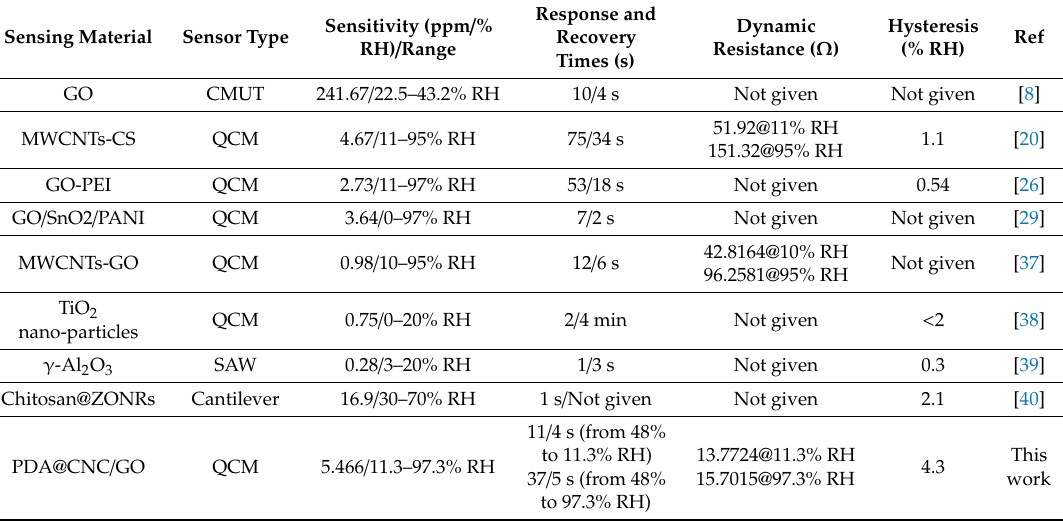
Table 2. Performance comparison between the proposed sensor in this work and other recent state-of-the-art humidity